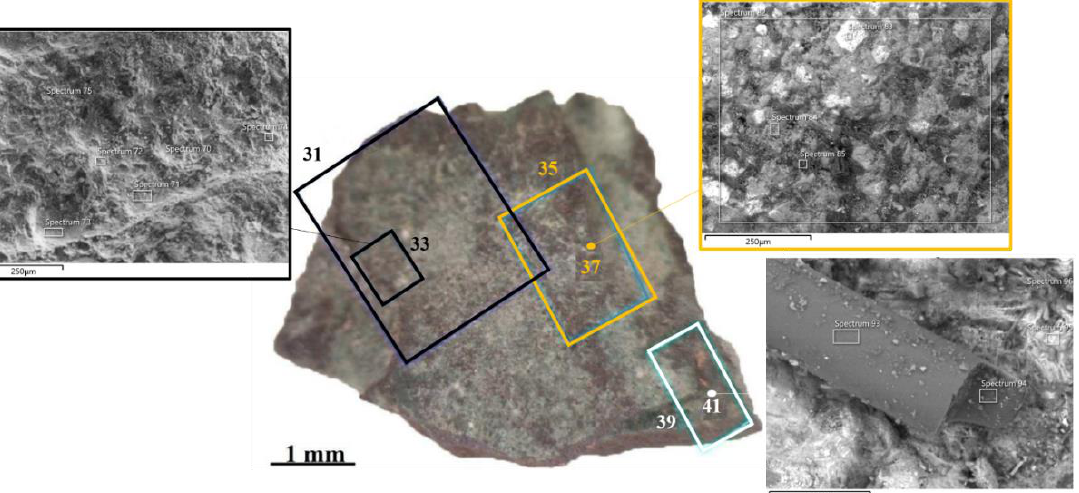
Figure 13. Schematic of the areas investigated by SEM-EDS for sample 25. Area 31, colored in black, presented the green patina. Detail 33 had been analyzed on the edge from which the underlying part was distinguishable. Area 35, colored in yellow, presented a white patina, of which the edge was then analyzed (detail 37). A copper-colored accumulation (area 39, colored in white) and detail 41 of green patina under the concentration mentioned above. SEM images are related to detail 33 (in black), detail 37 (in yellow) and detail 41 (in white).